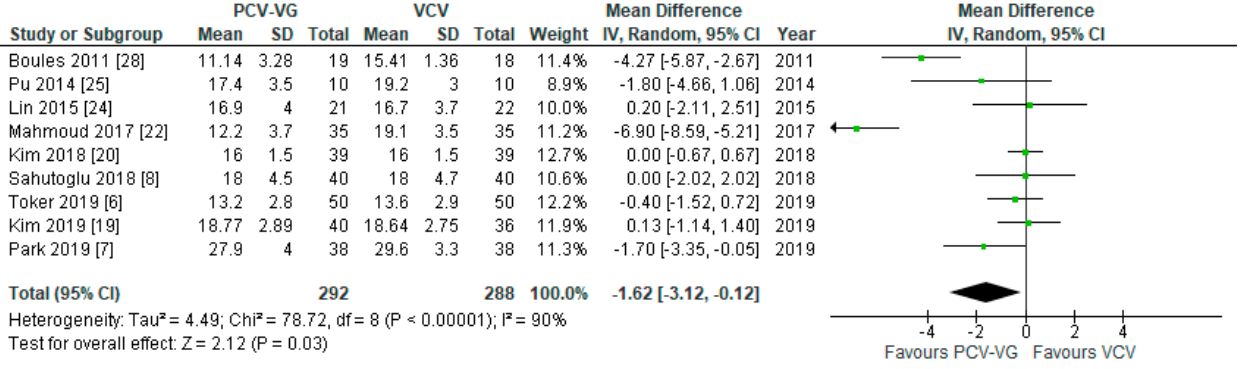
Figure 6. Mean airway pressure (P mean ): supine, two-lung ventilation. The green center of each square represents the weighted mean difference for individual trials, and the corresponding horizontal line stands for a 95% confidence interval. The diamonds represent pooled results. Figure 7. Dynamic compliance (C dyn ): supine, two-lung ventilation. The green center of each square represents the weighted mean difference for individual trials, and the corresponding horizontal line stands for a 95% confidence interval. The diamonds represent pooled results.